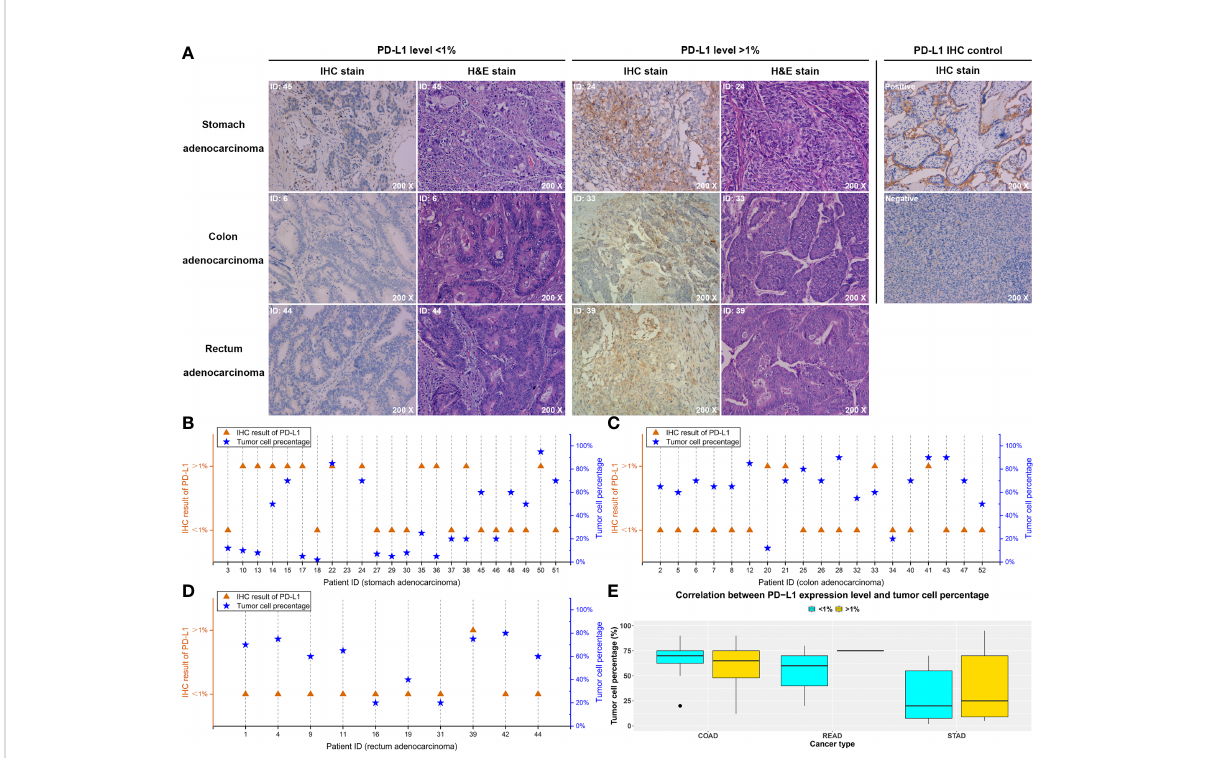
FIGURE 2 IHC test of the PD-L1 expression level and pathological staining results. On the basis of the IHC results, each patient was divided into high level (> 1%) and low level (< 1%) of PD-L1 expression. (A) Typical images of stomach, colon, and rectum adenocarcinoma, respectively, and the corresponding pathological results. (B – D) The relationship between the PD-L1 expression levels detected by IHC and the tumor cell percentages of each tissue specimen in the stomach, colon, and rectum adenocarcinoma, respectively. (E) The statistical analysis of the correlation between PD-L1 expression level and tumor cell